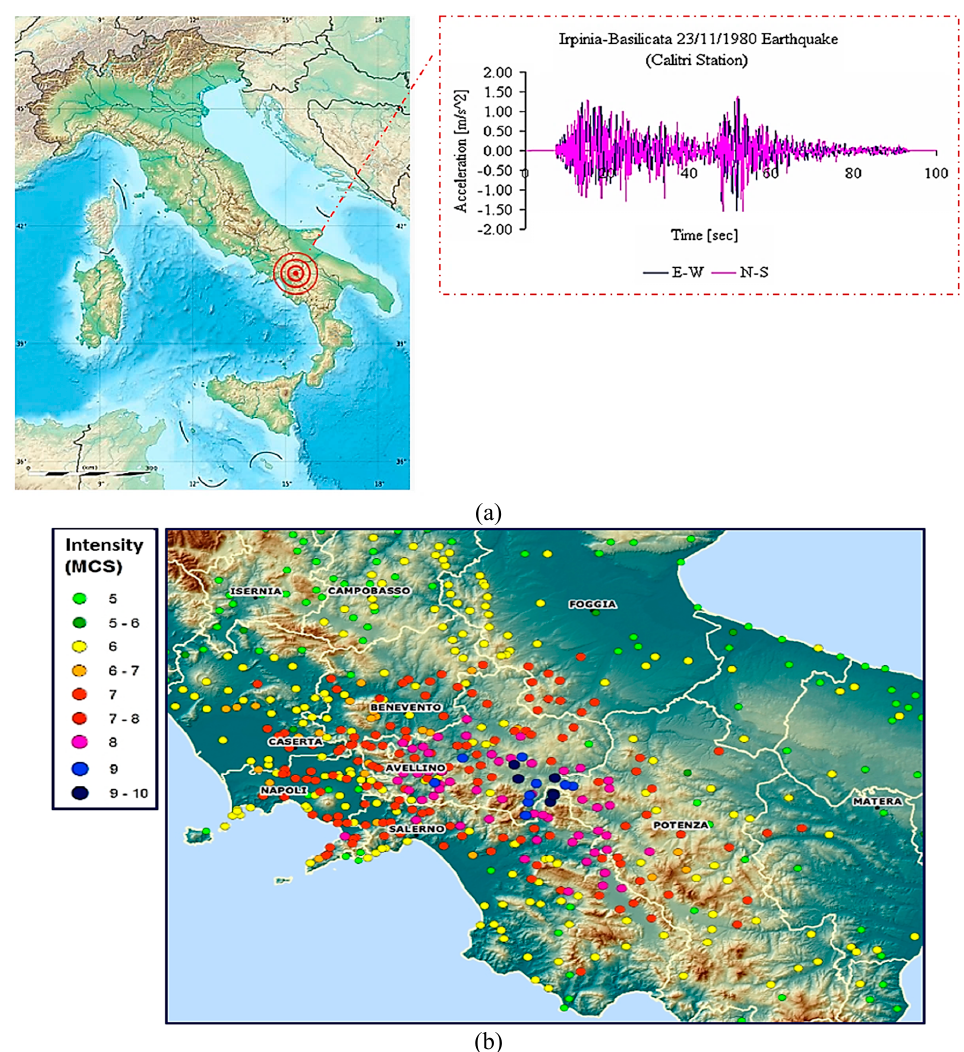
Figure 2. The Irpinia earthquake effects [23]: ( a ) time history main shock; ( b ) distribution of seismic intensities.